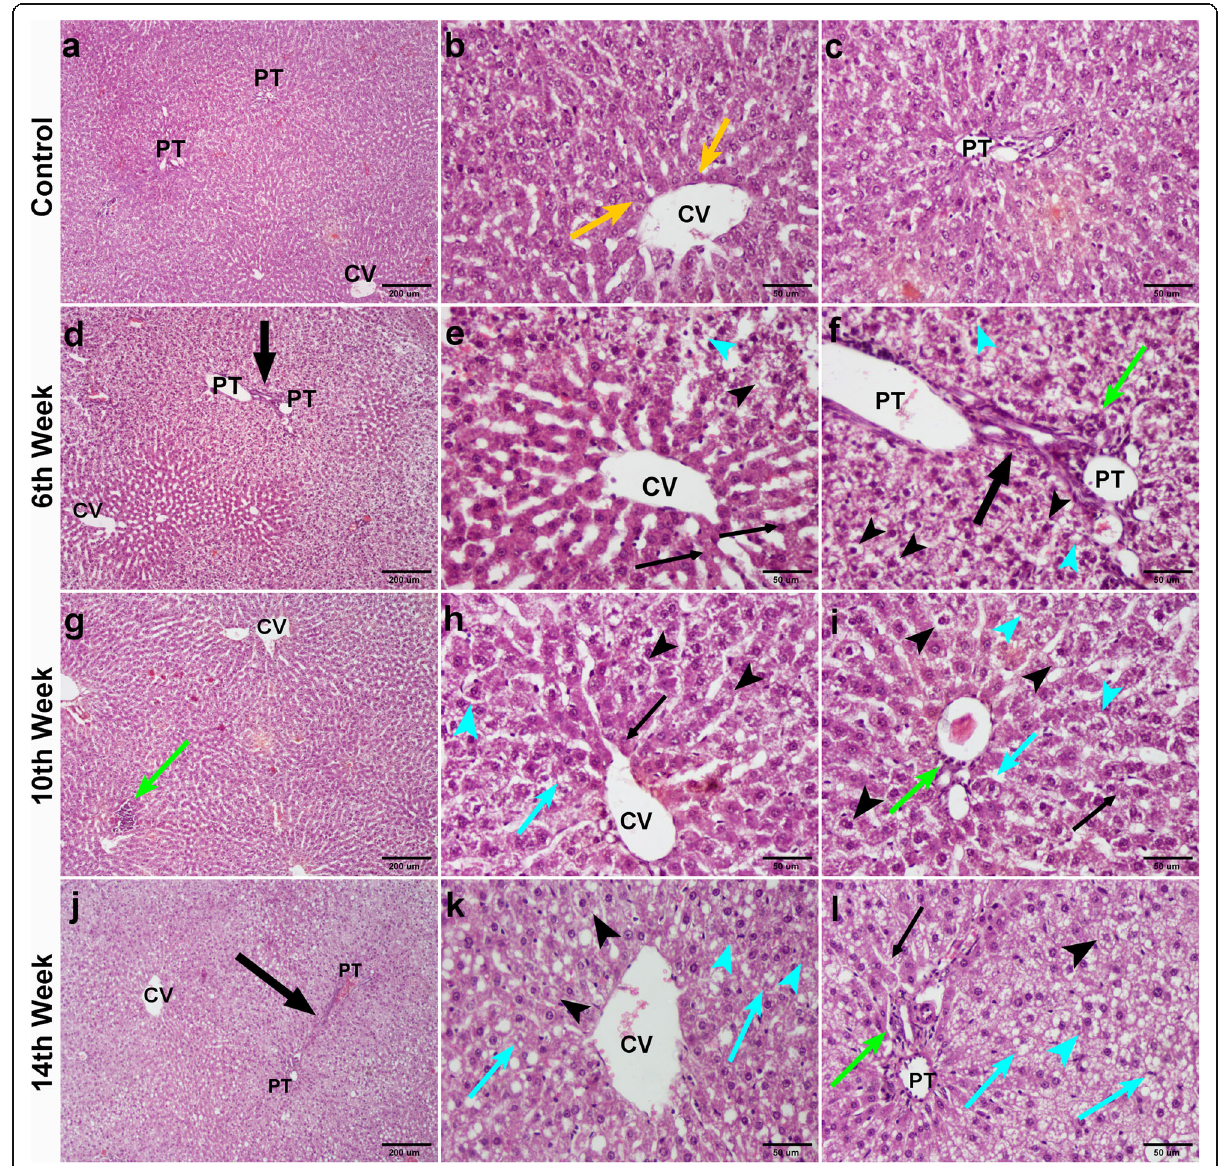
Fig. 3 a – c Photomicrographs of rat liver of control group showing normal liver architecture where cords of hepatocytes (orange arrows) radiating from central vein (CV). Hepatocytes are polyhedral in shape with vesicular nuclei and slightly vacuolated acidophilic granular cytoplasm. The hepatic cords are separated by blood sinusoids. Portal tract (PT) at the periphery of the hepatic lobule showing its three components, a branch of the portal vein, a branch of the hepatic artery, and a bile duct, is enclosed by a scanty amount of connective tissue. d – l Photomicrographs of rat liver of NAFLD group at different time intervals of HFD induction (6th, 10th, and 14th week) showing a disturbed liver architecture. Hepatocytes show micro- (thin black arrows), macro-vesicular steatosis (thin blue arrows), ballooning degeneration with rarefied cytoplasm (black arrowheads), and Mallory Denk bodies (blue arrowheads). Lobular and periportal cellular infiltrates are seen (thin green arrows) Notice periportal and bridging fibrosis (thick black